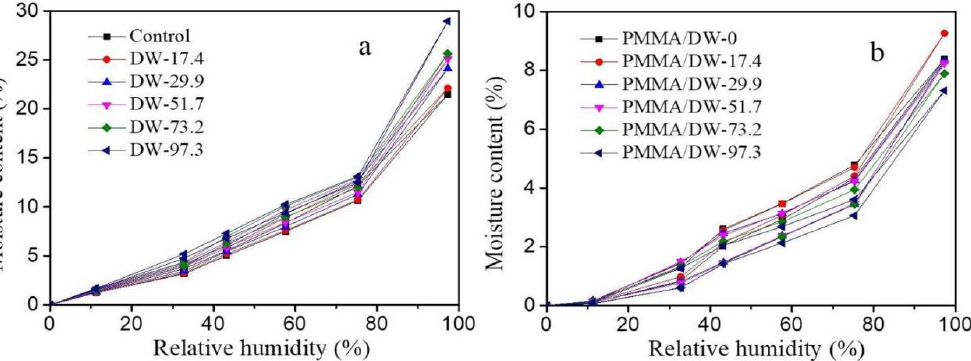
Figure 2. Moisture content change with relative humidity of DW ( a ) and PMMA/DW ( b ) during adsorption and desorption process.